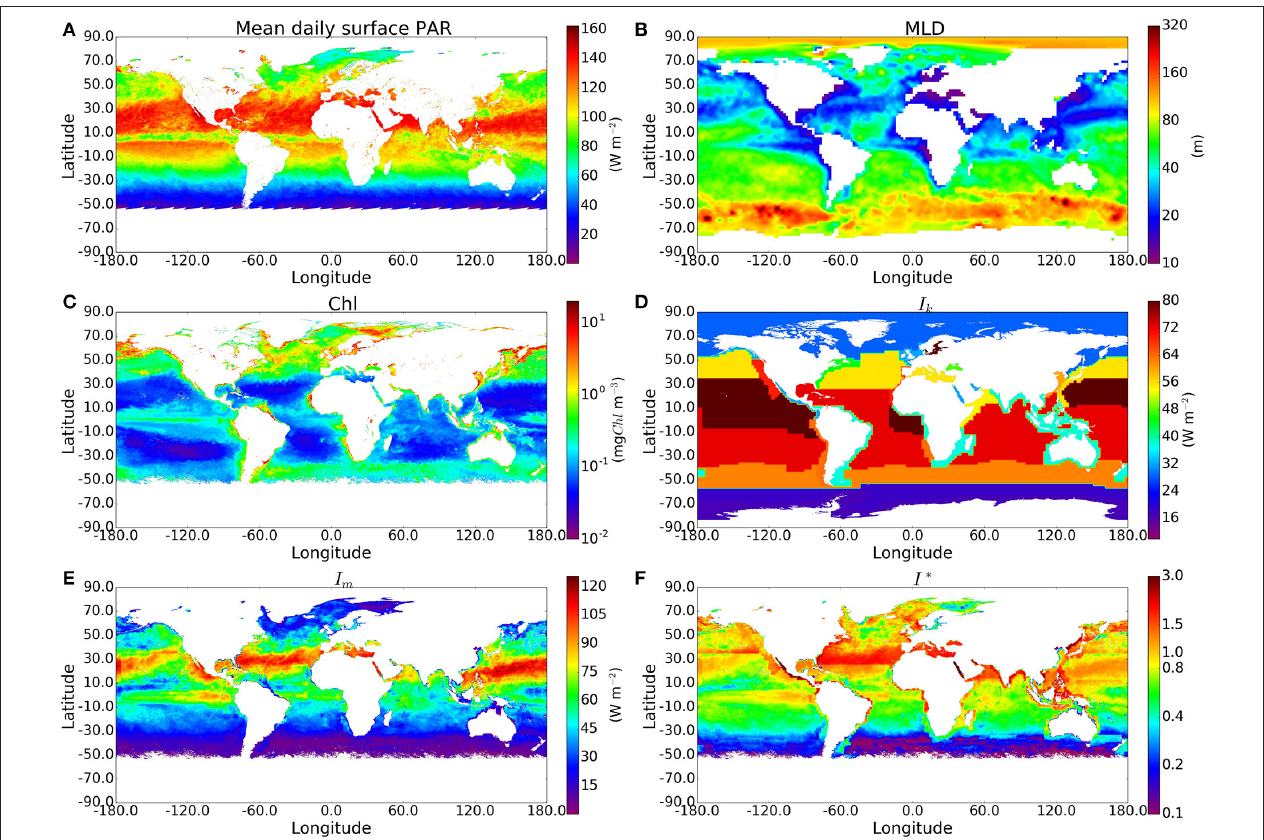
FIGURE 2 | Map showing the input data and resulting I * estimates at the global scale during May 2010. (A) SeaWiFS PAR product converted into W m − 2 (Morel and Smith, 1974) and averaged over the day (24 h), (B) MLD climatology (de Boyer Montégut et al., 2004), (C) OC-CCI v2.0 monthly composite of chlorophyll-a, (D) Biogeochemical-province based I k (Mélin and Hoepffner, 2004), (E) daily-mean mixed-layer irradiance, and (F) daily-mean mixed-layer dimensionless irradiance. Values of I * around 0.8 or greater (yellow and warmer colors) will give a significant difference between the approximate and exact solutions for